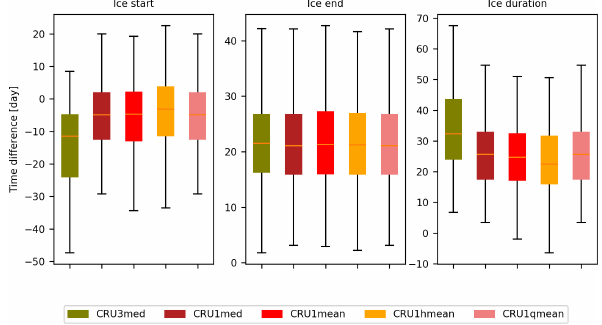
Figure 9. Boxplot of the RMSE errors on the start, end and dura- tion of the ice period for the five simulations CJR3med, CJR1med, CJR1mean, CJR1qmean and CJR1hmean. Median values are repre- sented by orange lines, and quartiles by the edges of the color